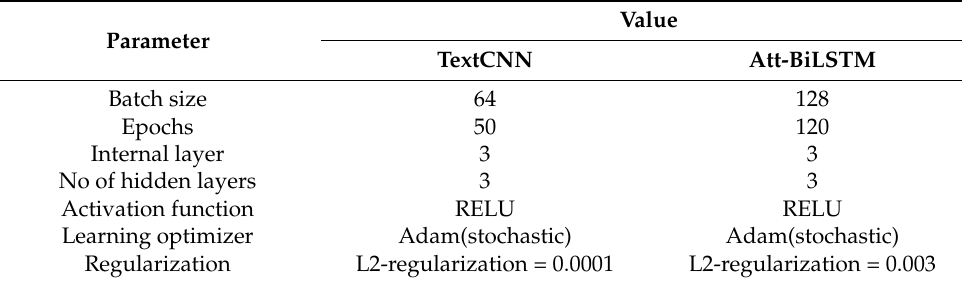
Table 2. Parameter Setting of Three